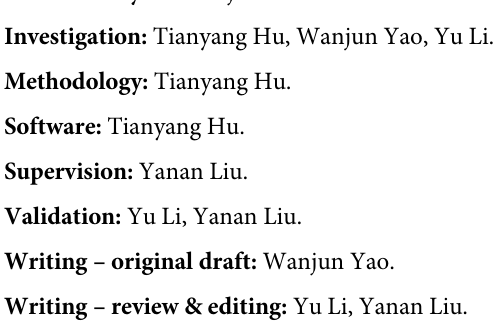
S1 Table. The baseline characteristics of all patients in validation cohort categorized by AHF and AKI. S2 Table. Cox analyses of factors associated with in-hospital mortality in validation